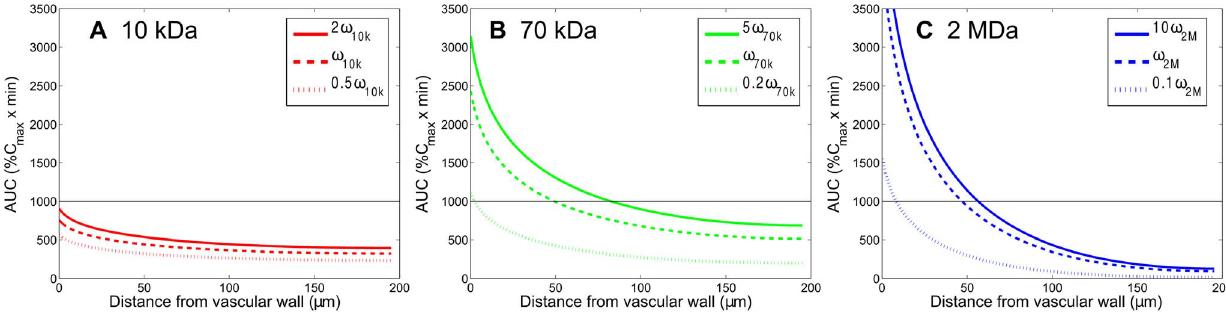
Figure 5. Effect of vascular permeability of carriers on the spatial distribution of accumulative exposure. The effect of vascular permeability of carriers on the spatial distribution of accumulative exposure (in the radial distance, up to 0 : 5% C max : ) (MW: 10 kDa, 70 kDa, 2 MDa) in the tumor interstitium. The horizontal lines show the value of AUC equal to 1000 % C max | min . The diffusion coefficient and plasma half-life time in this case are listed in Table 1 corresponding to each molecular weight.